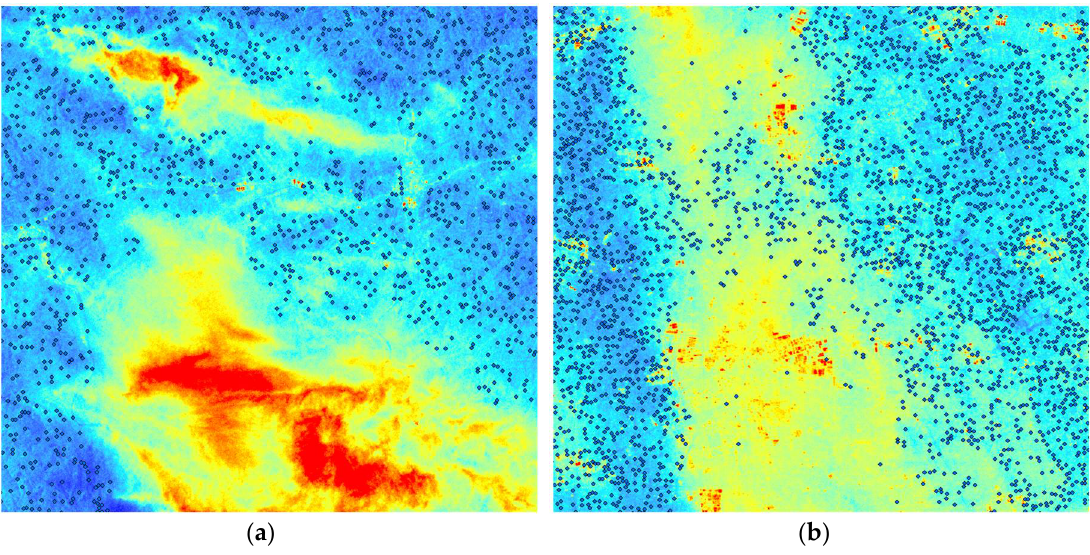
Figure 4. Schematic diagram of the BSHTI band, the color changing from red to blue indicates the thickness of cloud vary from thick to thin. ( a ) shows the vegetation area, and ( b ) shows the urban region.